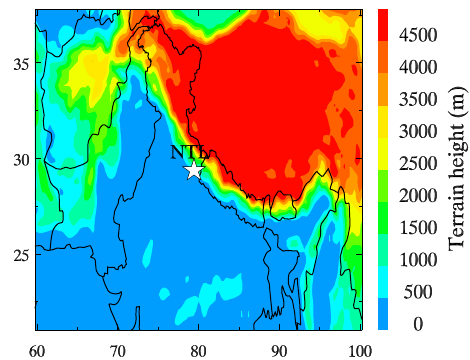
Figure 1. Location of the Nainital site in the central Himalayas shown on the topography map of the northern Indian